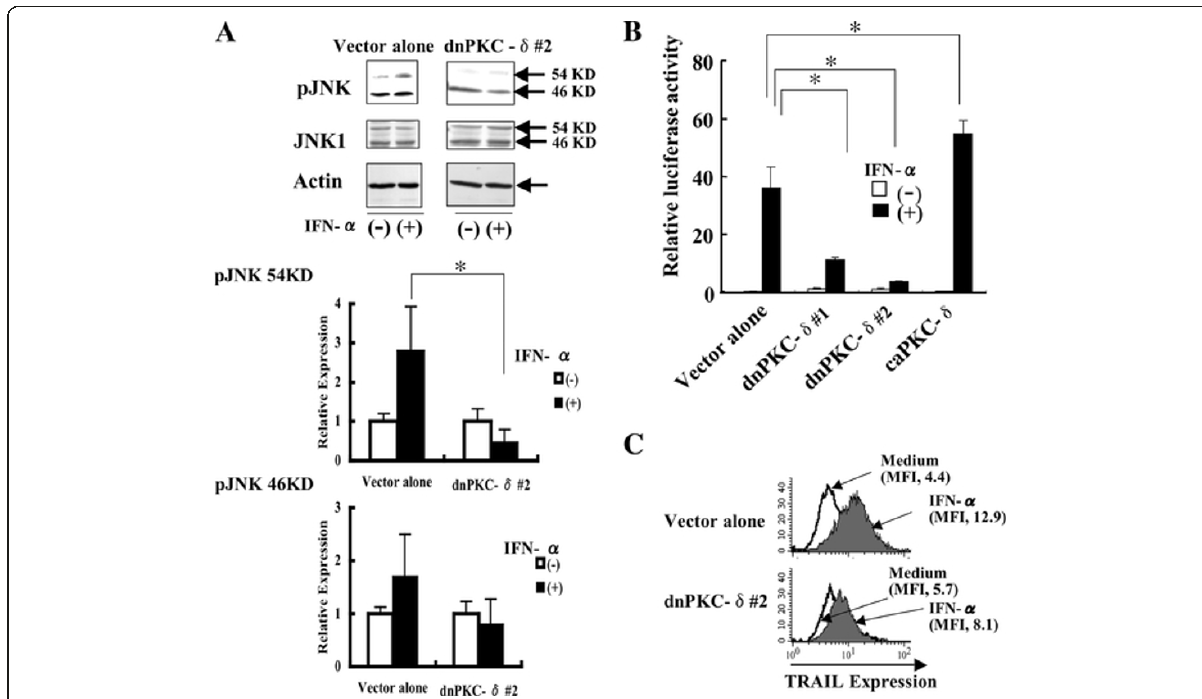
Figure 5 IFN- a -induced activation of JNK1 and TRAIL promoter is partially reduced in dnPKC- δ -expressing cells . The dnPKC- δ -expressing Daudi cells were stimulated with 1,000 U/ml IFN- a for 6 h, and the levels of phospho-JNK (A), TRAIL promoter activity (B), and TRAIL protein expression on the cell surface (C) were determined by Western blotting, the TRAIL-Luc reporter assay, and flow cytometry, respectively. MFI represents mean fluorescent intensity. The results from three independent experiments (B) are represented as mean ± SD. *Significantly different ( p < 0.05) from control vector alone.